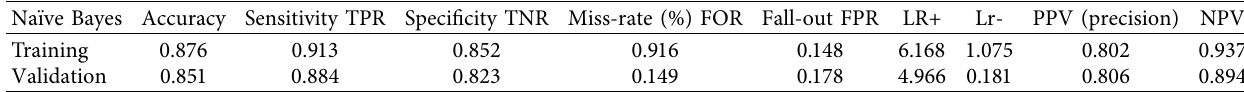
Table 6: Performance of proposed system in training and validation using different statistical measures (Na¨ıve Bayes).